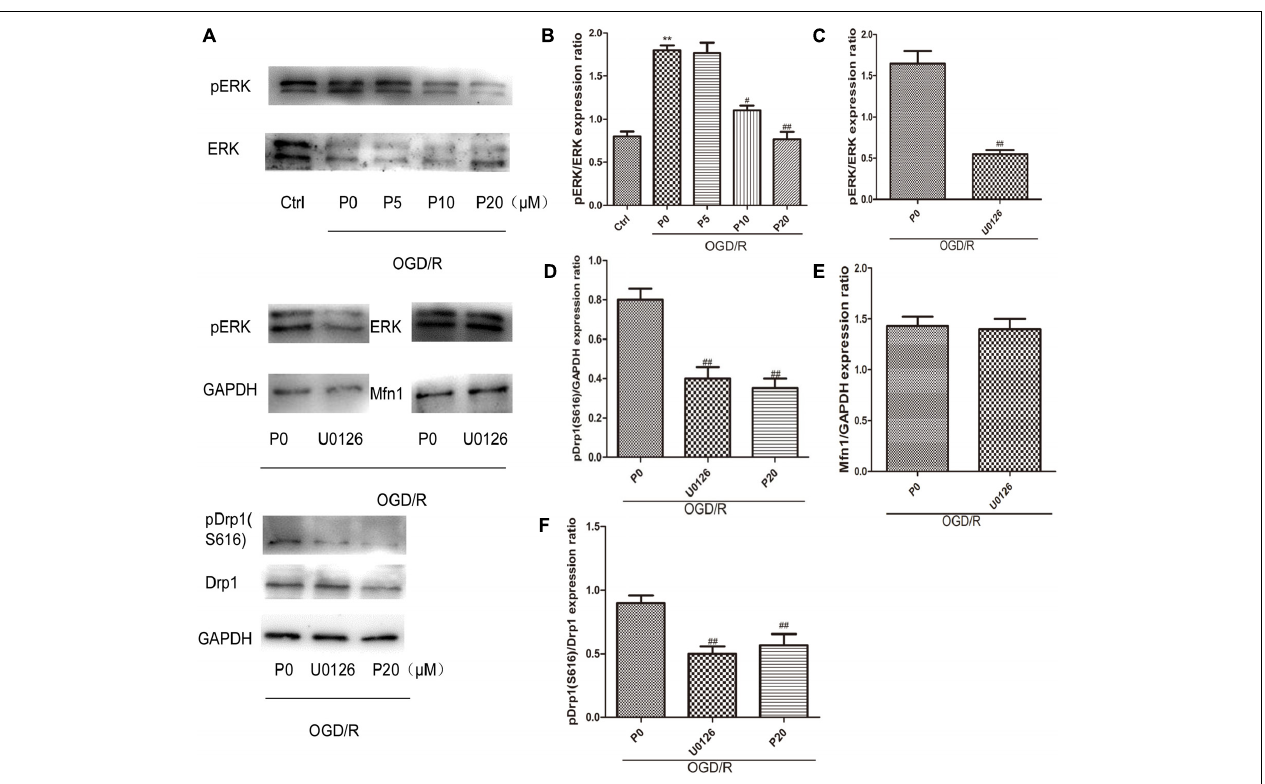
FIGURE 6 | Propofol could inhibit Drp1 phosphorylation through decreasing ERK activation in H9c2 cells during OGD/R. (A) Representative bands of pERK, ERK, pDrp1, Drp1 and Mfn1 by western blotting. (B) With the increase of propofol concentration (10, 20 µ M), the levels of pERK were significantly decreased during OGD/R injury. (C) U0126 can markedly inhibit ERK phosphorylation. (D,F) The levels of pDrp1 (S616) during OGD/R were significantly decreased by 20 µ M propofol and U0126. (E) There was no significant difference in the levels of Mfn1 between OGD/R group without propofol and OGD/R group with U0126. The data are presented as the mean ± SD of at least three independent experiments. ∗∗ P < 0.01 versus control, # P < 0.05, ## P < 0.01 versus OGD/R group without